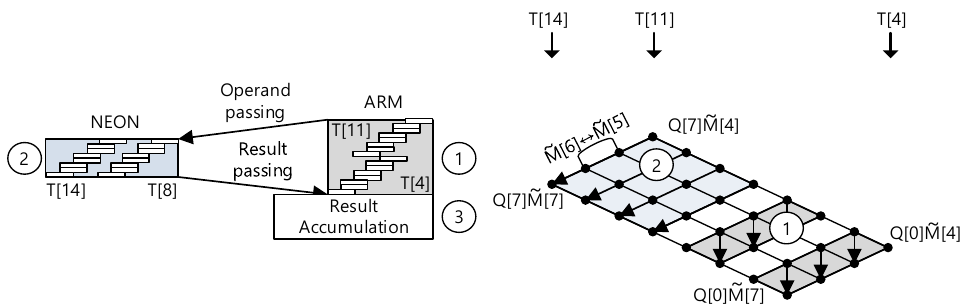
Figure 3: Unified 256-bit ARM/NEON Montgomery reduction at the word-level (8-word operand) for SIDH-friendly primes, 1 (cid:13) : sub-product on ARM; 2 (cid:13) : sub-product on NEON; 3 (cid:13) : result